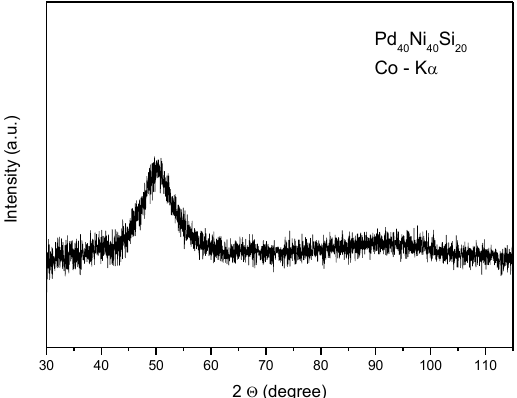
ff raction pattern of as-quenched Pd Figure 1. XRD diffraction pattern of as-quenched Pd 40 Ni 40 Si 20 alloy. Figure 1. XRD di